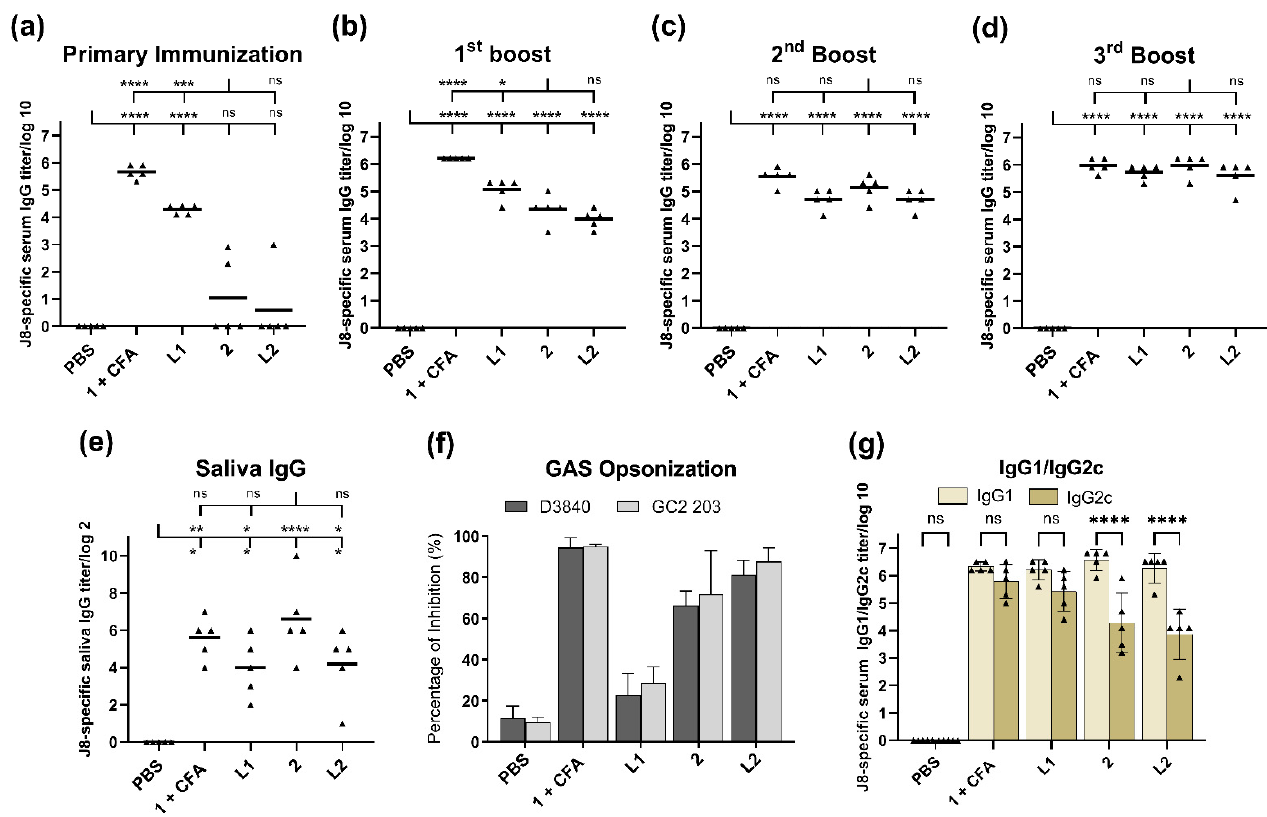
Figure 3. Immune responses after subcutaneous injection of PBS (negative control), compound 1 + CFA (positive control), compound 2 , and liposomes L1 and L2 in C57BL/6 mice ( n = 5). J8-specific serum IgG antibody titers after ( a ) primary immunization, ( b ) first, ( c ) second, and ( d ) third boosts, ( e ) J8-specific saliva IgG antibody titers, and ( f ) J8-specific IgG1/IgG2c ratio in the serum collected in the final bleed, as analyzed by ELISA. Each point (triangle) represents an individual mouse; bars represent the average antigen-specific IgG antibody titers. Statistical analysis was performed using one-way ANOVA with Tukey’s multiple comparison test ((*) p < 0.05, (**) p < 0.01, (***) p < 0.001, (****) p < 0.0001). ( g ) Average opsonization percentage of different GAS strains (D3840 and GC2 203) by serum collected on day 49 following the final immunization of C57BL/6 mice ( n = 5) with conjugate 2 , liposomes L1 and L2 , and controls. ns: not